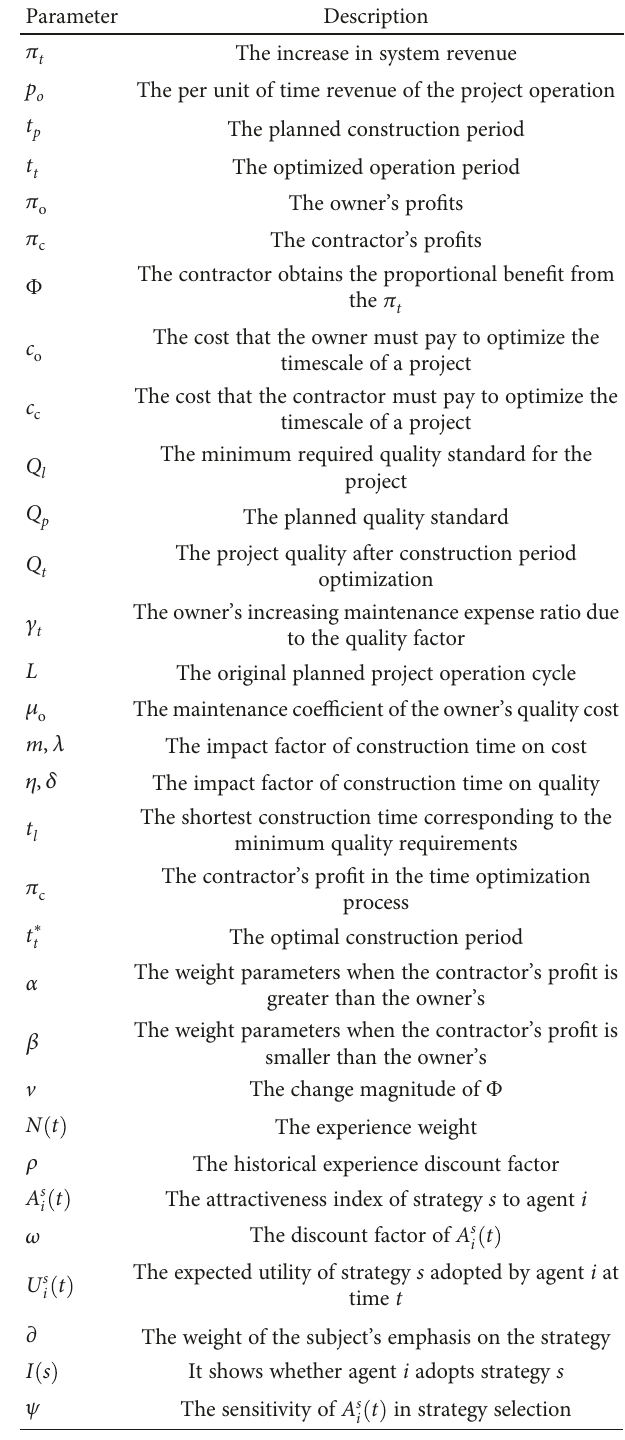
Table 1: The meaning of the parameters in the